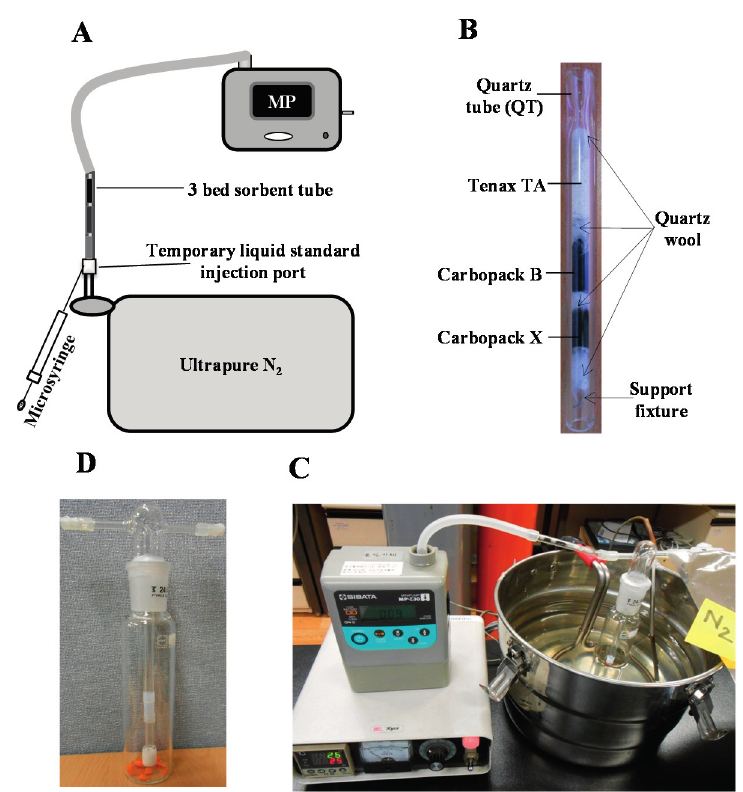
Figure 1. Schematic diagrams of monoterpenes (MTs) sampling apparatus and setup: ( A ) diagram of loading L-WS on ST; ( B ) picture of ST with 3-bed components; ( C ) experimental setup for headspace sampling, and ( D ) impinger containing sliced carrot